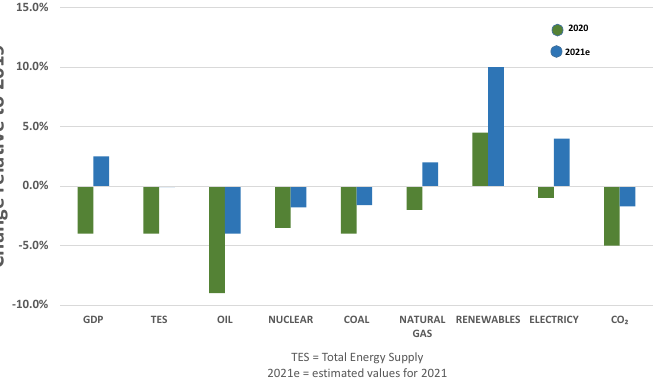
Figure 1. Change in key global indicators for energy demand and emissions, 2020 and 2021. Reprinted from Ref. [18].